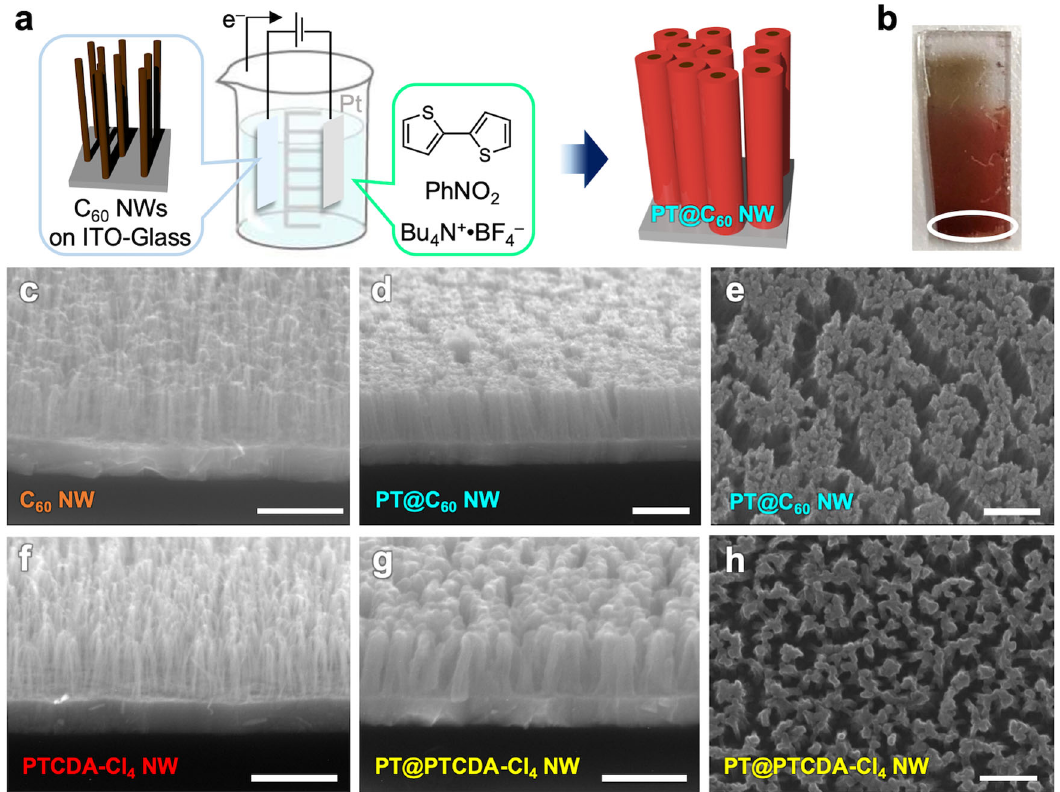
Fig. 6 Coaxial nanowire-type heterointerfaces. a Schematic illustration of fabrication protocol for free-standing coaxial nanowires by electropolymerization of bithiophene from C 60 nanowires on ITO-glass. b Example of coaxial nanowire fi lm. SEM images of c C 60 -based VA-NWs and d , e polythiophene-wrapped C 60 -based coaxial nanowires (PT@C 60 ) in white circled area in b . SEM images of f free-standing PTCDA-Cl 4 -based